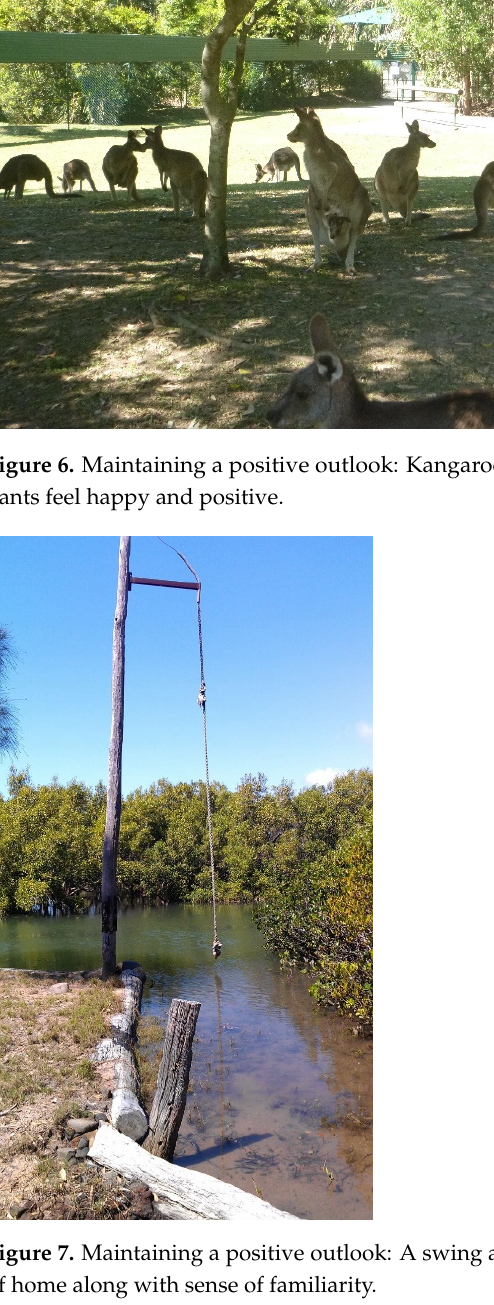
Figure 8. Maintaining a positive outlook: A stream in a forest to show a place that reminds of fam- ily time. 3.4. Centreing Yourself Many participants spoke about the importance of moments of dissociation from the outside world, daily concerns and challenges associated with living in an uncertain, fast- paced society and constant need to be “switched on”. This helped participants to centre themselves and carry on. The centreing yourself pathway relates to the process of restor- ing the balance between oneself and the external world where all the external worries become peripheral. By providing refuge from modern urban society, nature can facilitate centreing experiences by allowing participants to reconnect with the core self and experi- ence life inside out. In addition, nature appeared to bring participants to the present and retain them there for a little while. Overall, centreing experiences helped participants to reconnect